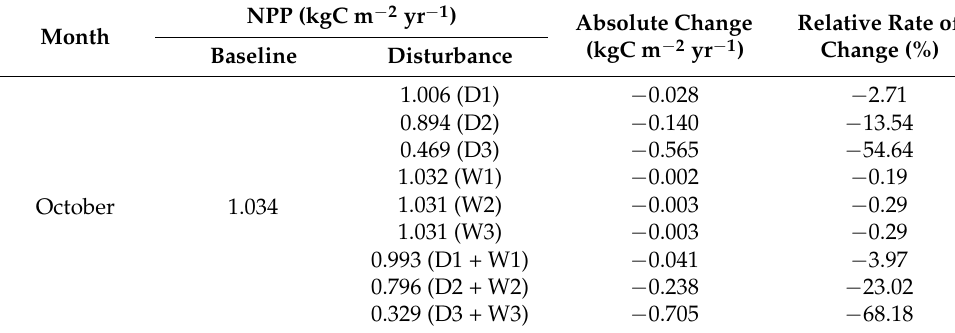
Table 6. Absolute change and relative change rate of NPP (kgC m − 2 yr − 1 ) after the drought and/or warming scenarios